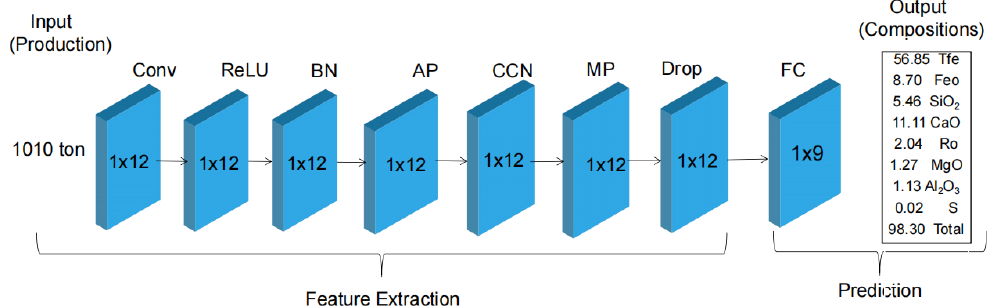
Figure 2. The architecture of our proposed SCORN for predicting the compositions of sinter at “production” 1010 ton (Conv: convolution, ReLU: rectified linear units, BN: Batch normalization, AP: average pooling, CCN: cross-channel normalization, MP: max pooling, Drop: dropout and FC: fully connected. The number of features of each layer is represented in the middle of the graph of each